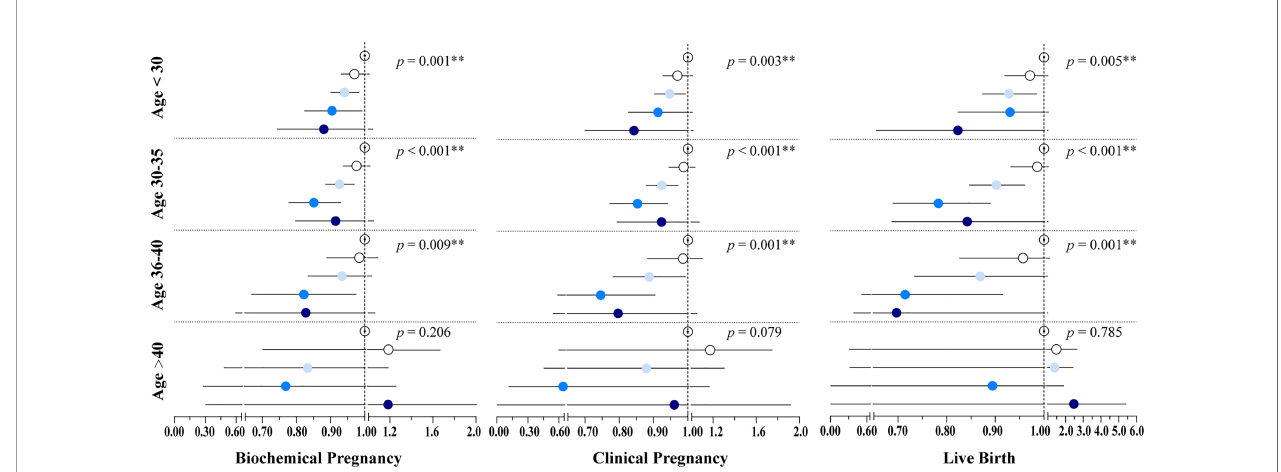
FIGURE 2 | Results of the Poisson regression assessing the associations between cryopreservation time and pregnancy outcomes by age groups. The models were adjusted by maternal age at OPU, BMI, infertility type, infertility cause, infertility duration, endometrium preparation regimen, the number of oocytes retrieved, and the stage, number, and quality of embryos transferred. Hollow, white, light blue, blue, and dark blue circles represent the adjusted RR for Group1, Group 2, Group 3, Group 4, and Group 5, respectively. Line segments represent the 95% CI. Group 1: 3 – 8 weeks; Group 2: 8 – 12 weeks; Group 3: 12 – 26 weeks; Group 4: 26 – 52 weeks; Group 5: > 52 weeks. *P < 0.05, **P <